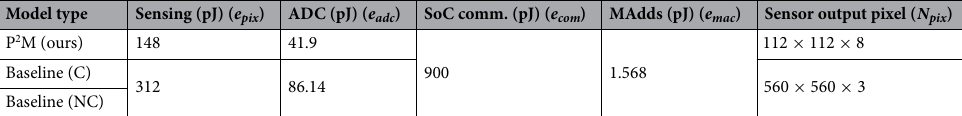
Table 5. Energy estimates for different hardware components. The energy values are measured for designs in 22 nm CMOS technology. Note, the sensing energy includes the analog convolution energy for P 2 M as analog convolution is performed as a part of the sensing operation. For the e mac , we convert the corresponding value in 45 nm to that of 22 nm by following standard scaling strategy 47